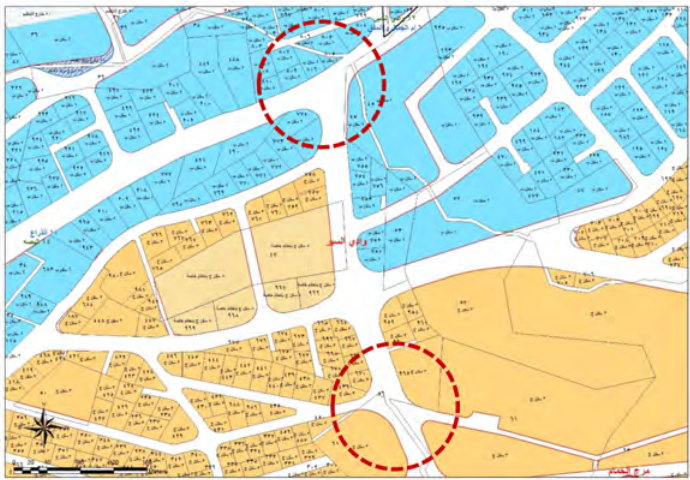
Figure 28. Near high voltage site land use map. Source: GAM- GIS for the author (2016).